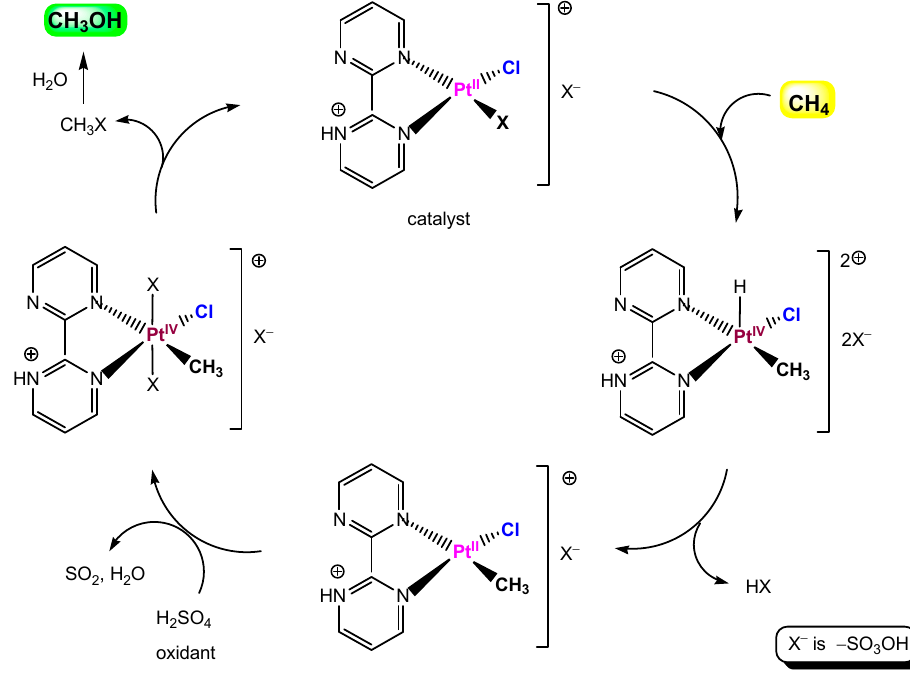
Figure 22. A catalytic cycle for the methane oxidation by Periana system.